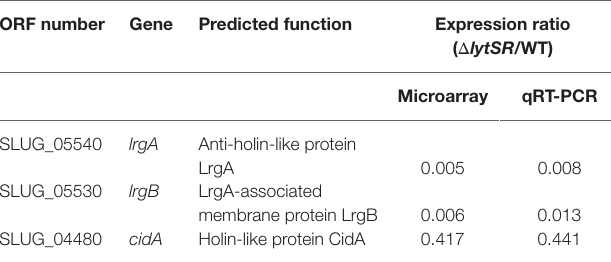
TABLE 4 | Expression of genes regulated by LytSR confirmed by qRT-PCR. ORF number Gene Predicted